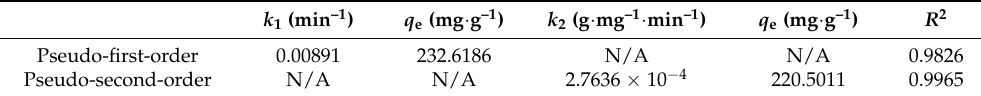
Table 4. Adsorption dynamic model fitting